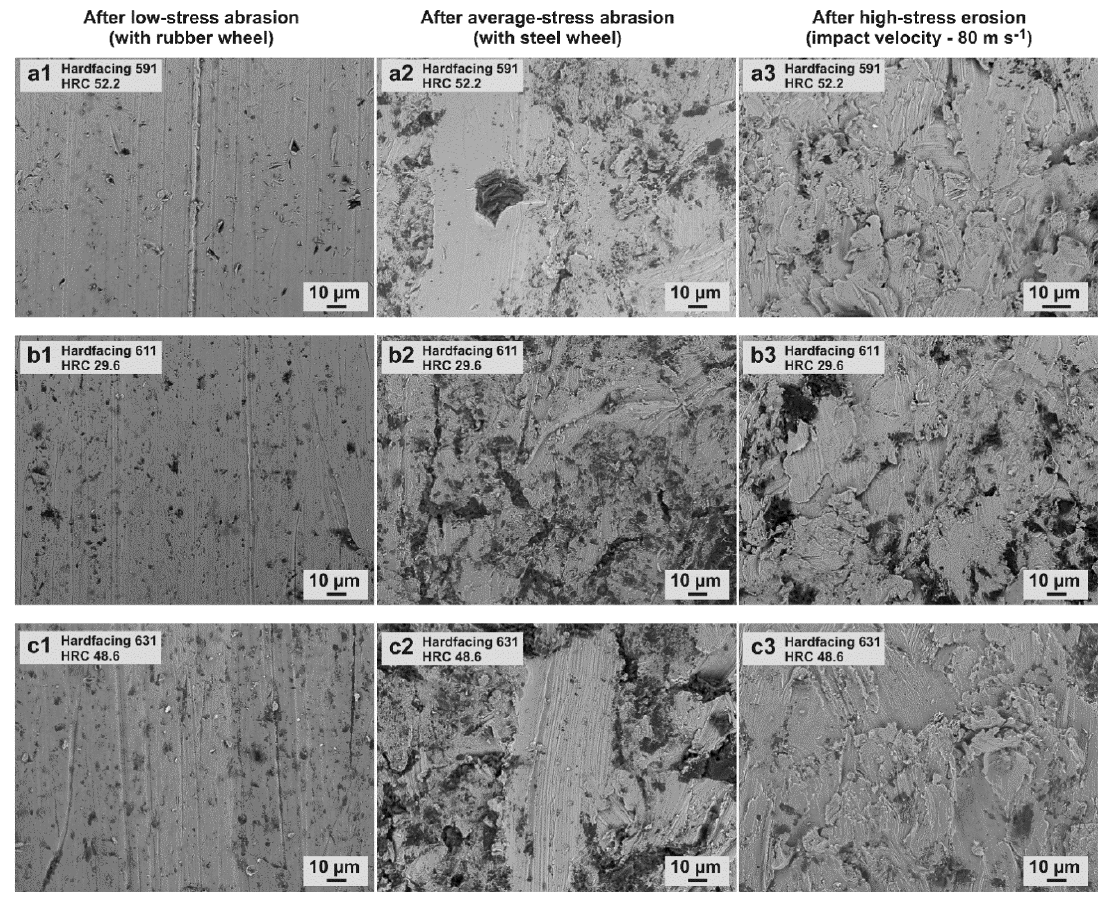
Figure 9. SEM images of the characteristic surfaces worn under low-, average-, and high-stress abrasive and erosive conditions.